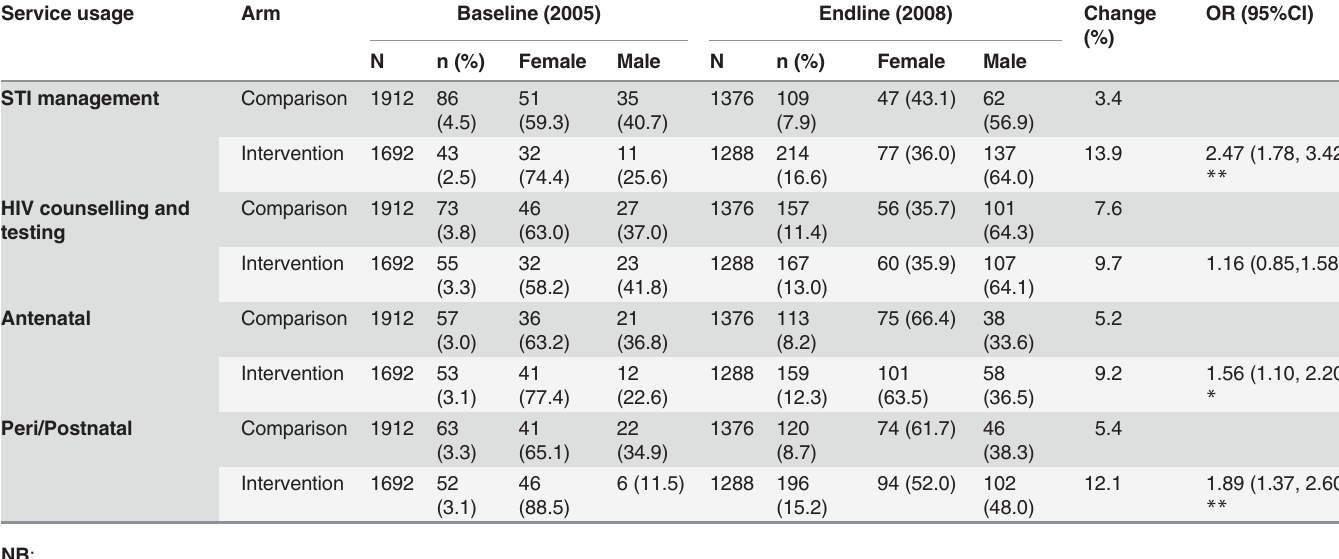
Table 2. Frequency of service usage, change over time and odds ratios with 95% confidence intervals, comparing intervention to comparison re- sponses at baseline and endline. Service